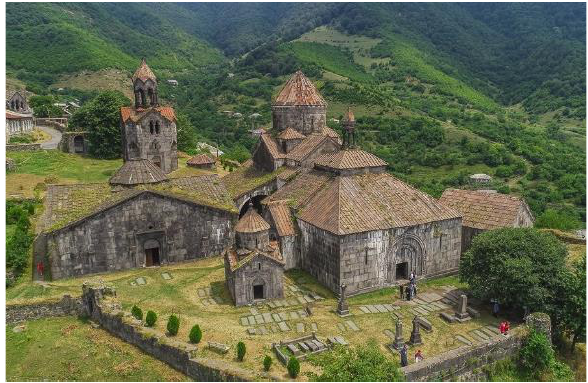
Figure 6. Monastery of Haghpat. ©Andranik Keshishyan